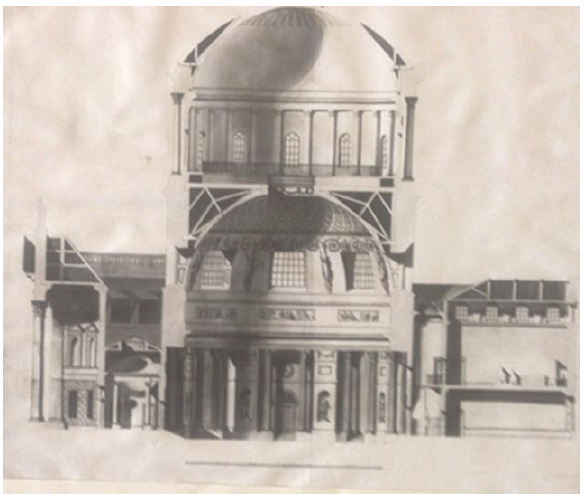
Figure 5: 18 th Century Section of Four Courts (Architect Gandon)